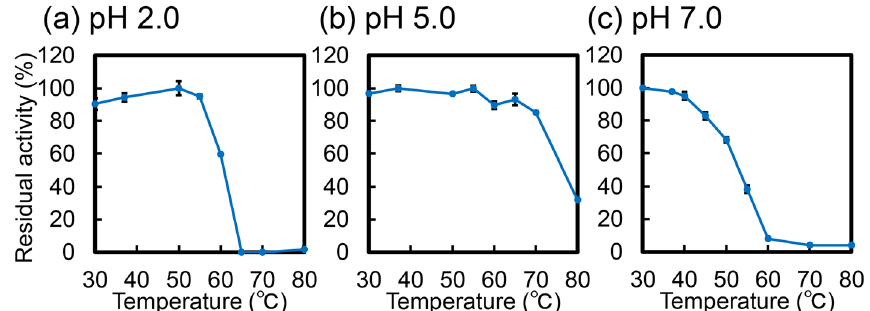
Figure 5. Temperature stability of Mf -CHIA. Mf -CHIA were incubated at pH 2.0, 5.0 and 7.0 for 30 min in McIlvaine’s buffer for 15 min between 30 and 80 °C. After cooling on ice, the residual activity was measured at pH 5.0 (optimal pH condition of monkey CHIA) in McIlvaine’s buffer. ( a ) pH 2.0, ( b ) pH 5.0 and ( c ) pH 7.0. We show the relative activity when the highest residual activity of Mf -CHIA was set to 100%. The chitinolytic activities are expressed with the subtraction of the blank experiments. Error bars represent mean ± standard deviation from a single experiment conducted in triplicate.